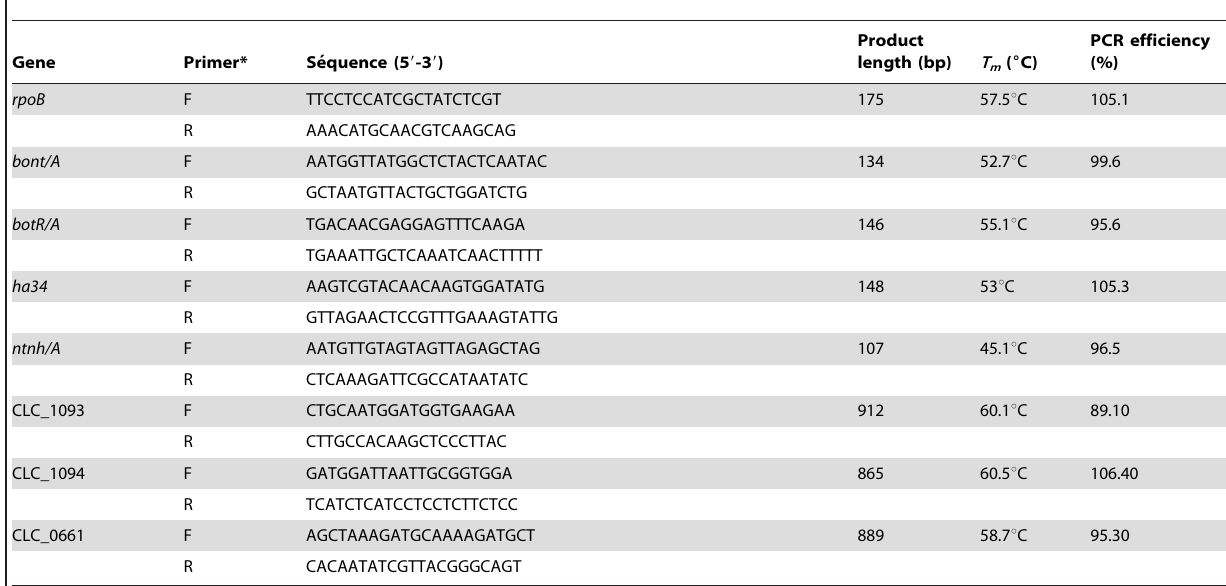
Table 1. Primers used to amplify internal fragments of the target genes by quantitative reverse transcriptase PCR.